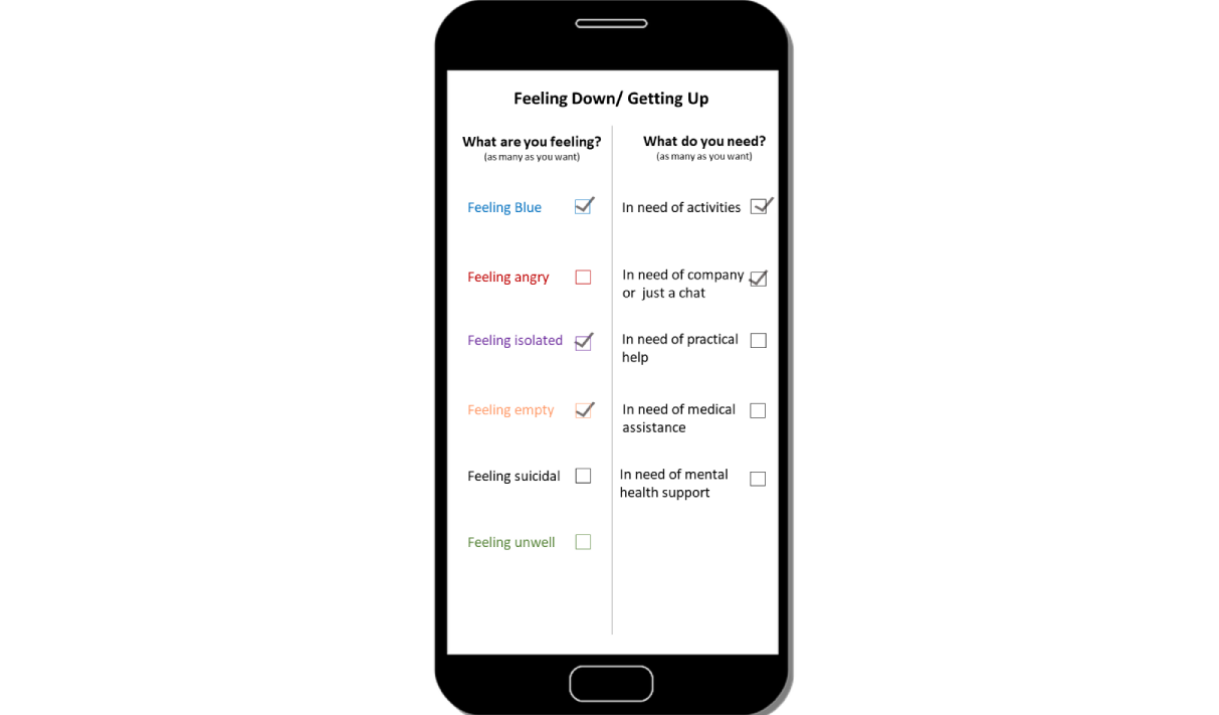
Figure 1. App prototype of a digital tool to support health and